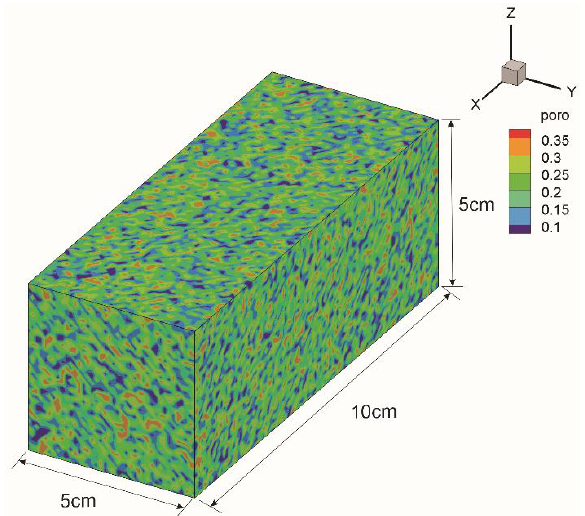
Figure 4. The dimension of the core sample and the initial porosity distribution with fluctuation in the interval [−0.15, 0.15]. Table 1. Initial and injected concentrations of aqueous species.